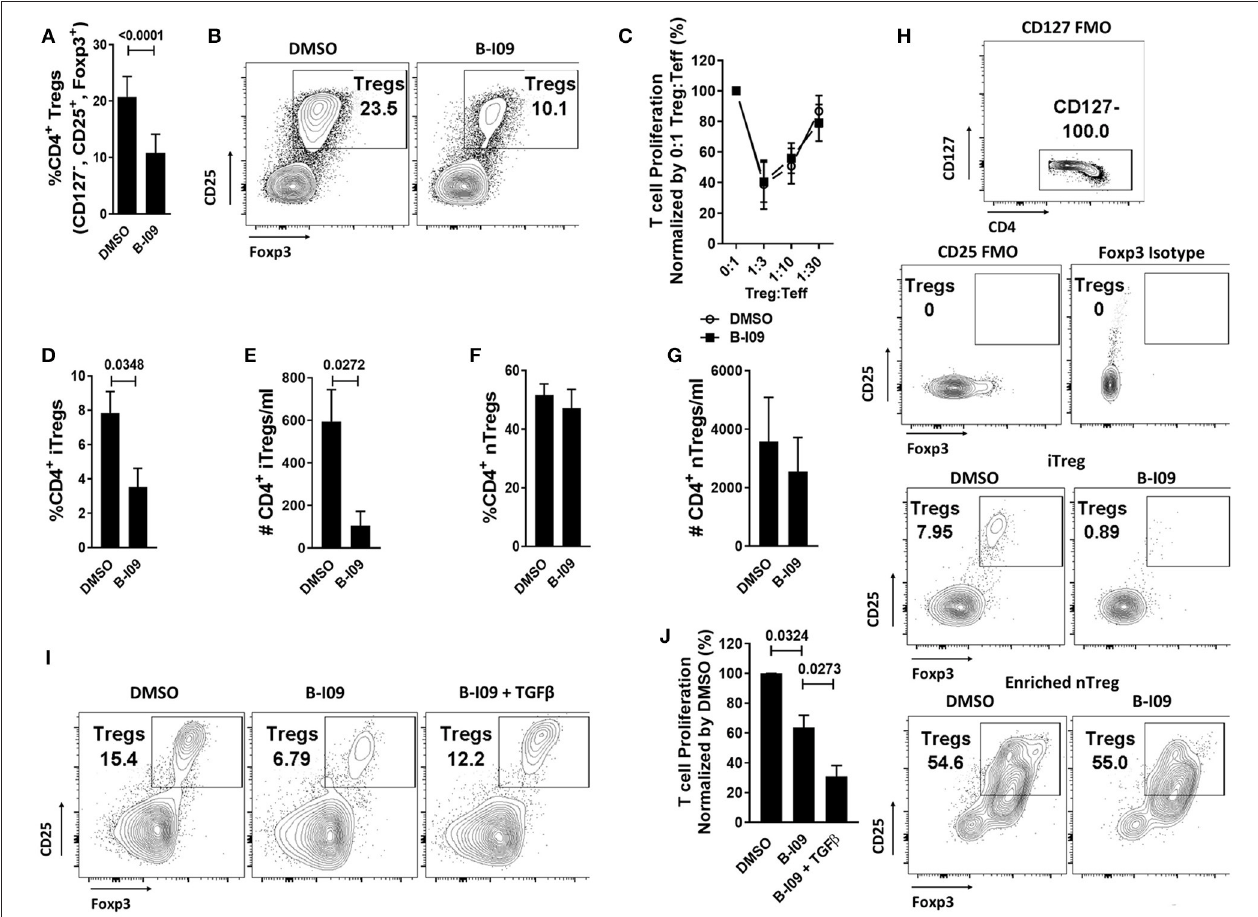
FIGURE 4 | moDC XBP-1s direct human iTreg differentiation via TGF β . T cells were cultured with B-I09 or DMSO pre-treated moDCs (moDC:T cell ratio of 1:30), and additional B-I09 (20 µ M) or DMSO (0.1%) was added once on day 0. (A) Percentage of Tregs (CD4 + , CD127 − , CD25 + , Foxp3 + ) in the 5-day co-cultures, with representative contour plots shown (B) . Means from 6 independent experiments are shown. (C) The suppressive capacity of harvested moDC-allostimulated Tregs was tested at different ratios of Treg to T cell responders stimulated by fresh allogeneic moDCs (moDC:responder T cell ratio 1:30) in alloMLRs. No additional B-I09 or DMSO was added. Graph shows mean percent T effector (Teff) proliferation measured by Ki-67. Means from 3 independent experiments are shown. To generate inducible Tregs, Treg-depleted CD4 + Tconv were stimulated by B-I09 or DMSO-pretreated allogeneic moDCs at a moDC:T cell ratio of 1:30. B-I09 or DMSO was added once on day 0. Magnetic bead enriched natural Tregs (CD4 + , CD25 + ) were similarly treated in allogeneic Treg:moDC co-cultures. Treg populations were evaluated by flow cytometry on day + 5. Means from 4 iTreg and 4 nTreg independent experiments are shown, paired t -test. Percentage and absolute number of iTreg (D,E) and nTreg (F,G) are shown. (H) Representative contour plots are shown for iTreg and nTreg. (I) Representative contour plots show that adding recombinant human TGF β rescues iTreg generation in Treg-depleted alloMLRs treated with B-I09 vs. DMSO. 1 representative experiment of 2 independent studies is shown. (J) T cell proliferation (MTS colormetric assay) at day + 5 among Treg-depleted alloMLRs treated with B-I09 or DMSO, with recombinant human TGF β added as indicated. Replicate means from 4 independent experiments are shown, Dunnett’s test.